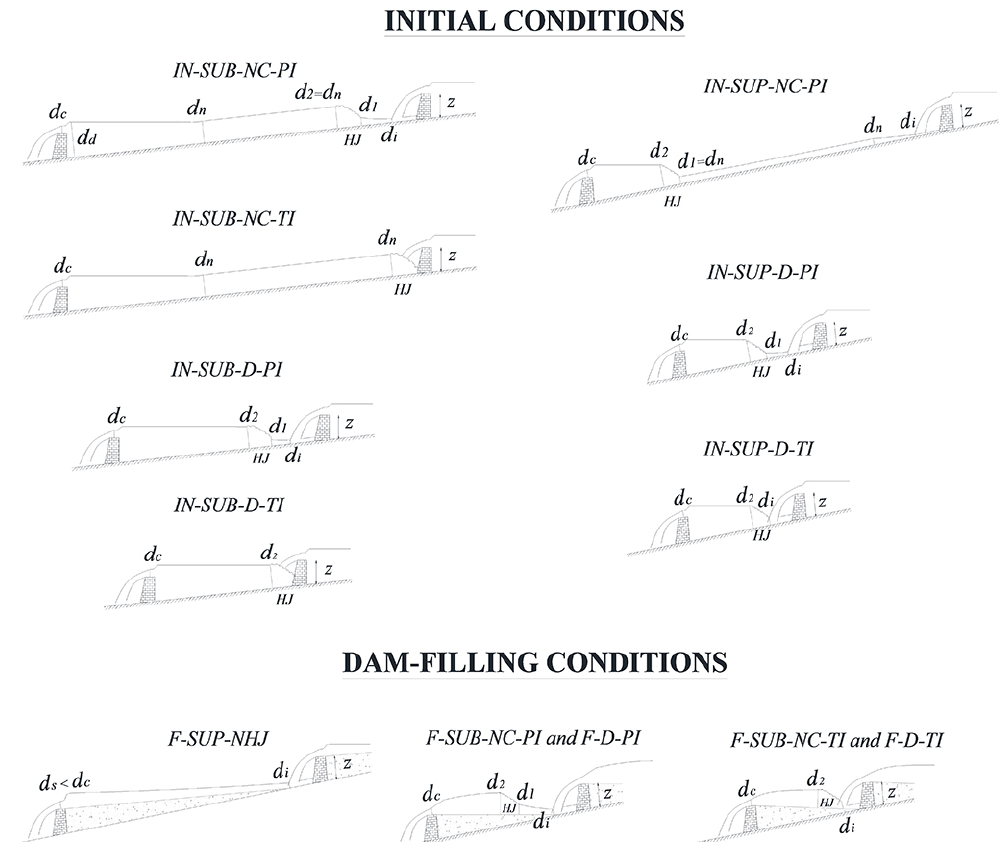
Fig. 4. Classification of flow regime typologies in restored gullies. d c represents the critical depth; d n the normal depth; d s the depth over the spillway; d 1 the supercritical depth at the hydraulic jump; d 2 the subcritical depth at the hydraulic jump; D the check dam influence; F the dam-filling conditions; IN the initial conditions; NC the normal conditions influence; NHJ the no hydraulic jump; PI the partial influence; SUB the subcritical normal conditions; SUP the supercritical normal conditions; TI the total influence.